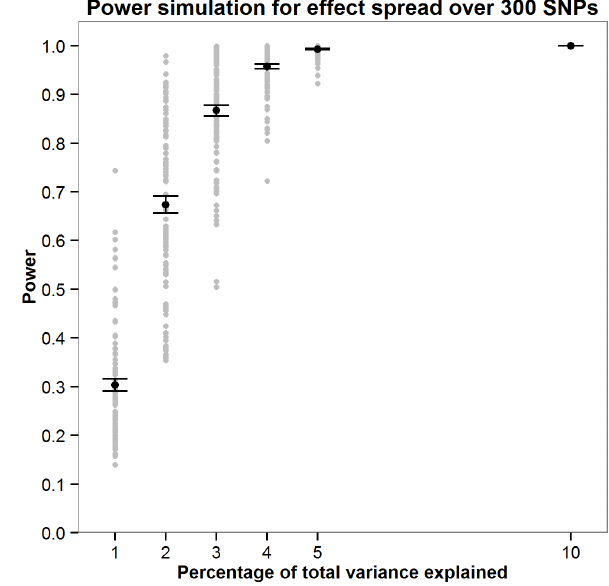
Figure 3. Simulations exploring how power fuctuates as a function of total variance explained when the effect is spread over 100 SNPs. For each effect size (1,2,3,4,5 or 10% of the total variance) 100 simulations were carried out. The mean power from these 100 simulations is shown in red with error bars depicting 6 1 standard error.